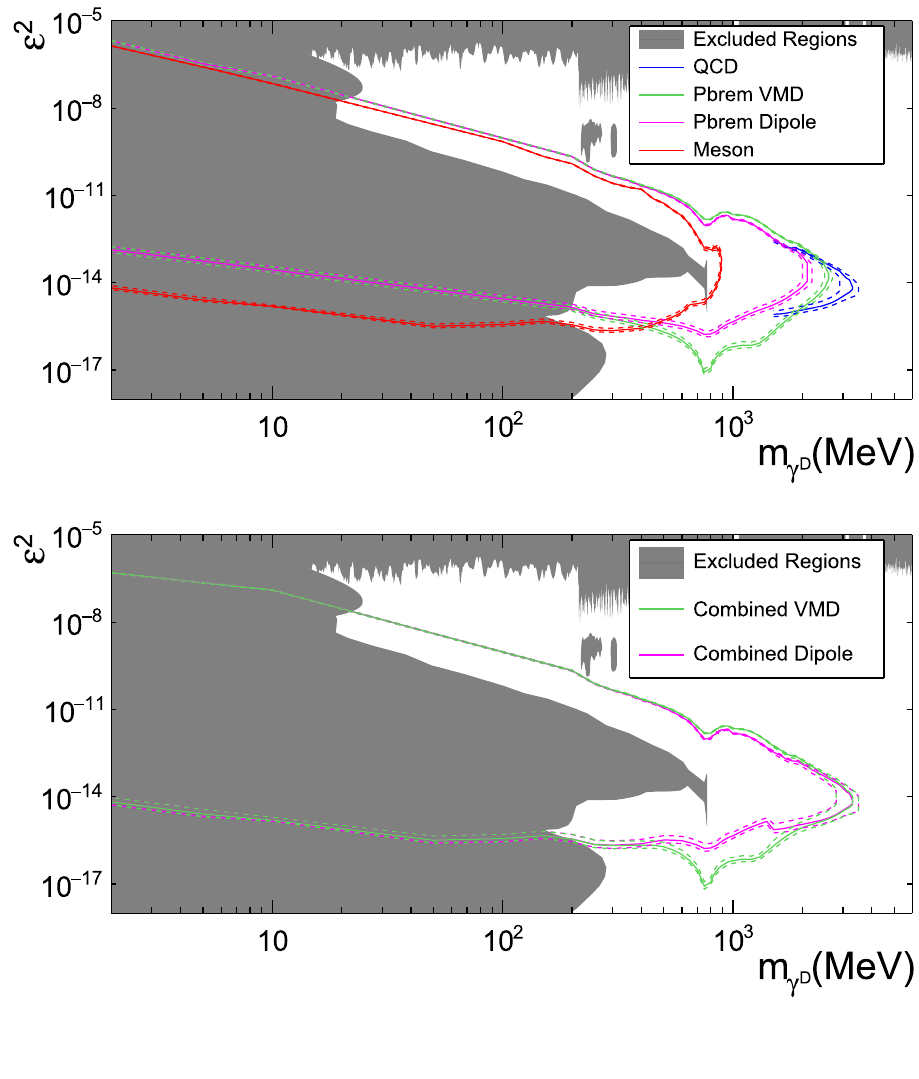
pink (dashed blue) lines show the result of the interpolation (varying the yields up and down according to the total systematic uncertainties detailed in Sect. 4.4)